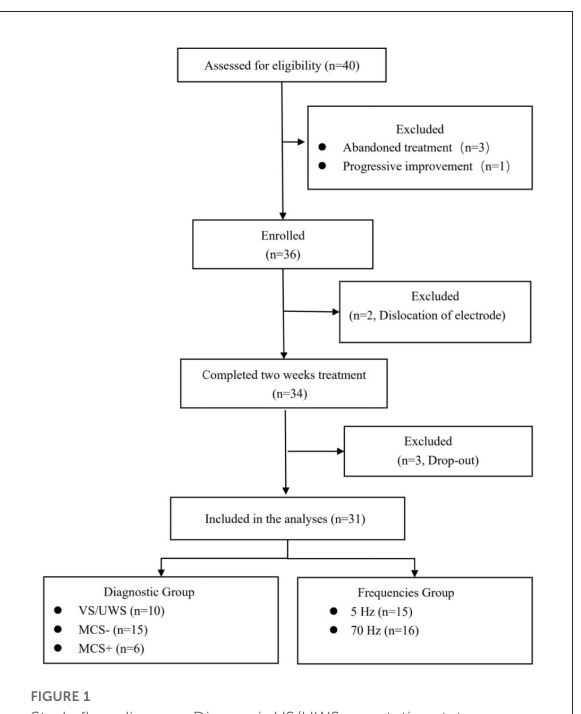
FIGURE1 Study flow diagram. Diagnosis VS/UWS, vegetative state or unresponsive Wakefulness Syndrome; MCS − , minimally conscious state minus; MCS + , Minimally Conscious State